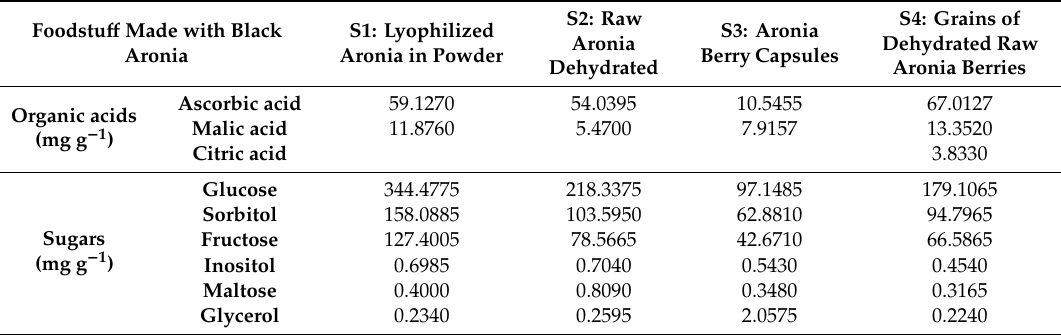
Table 6. Quantification of organic acids and sugars ( n = 3) in commercial samples of black aronia applying the optimal